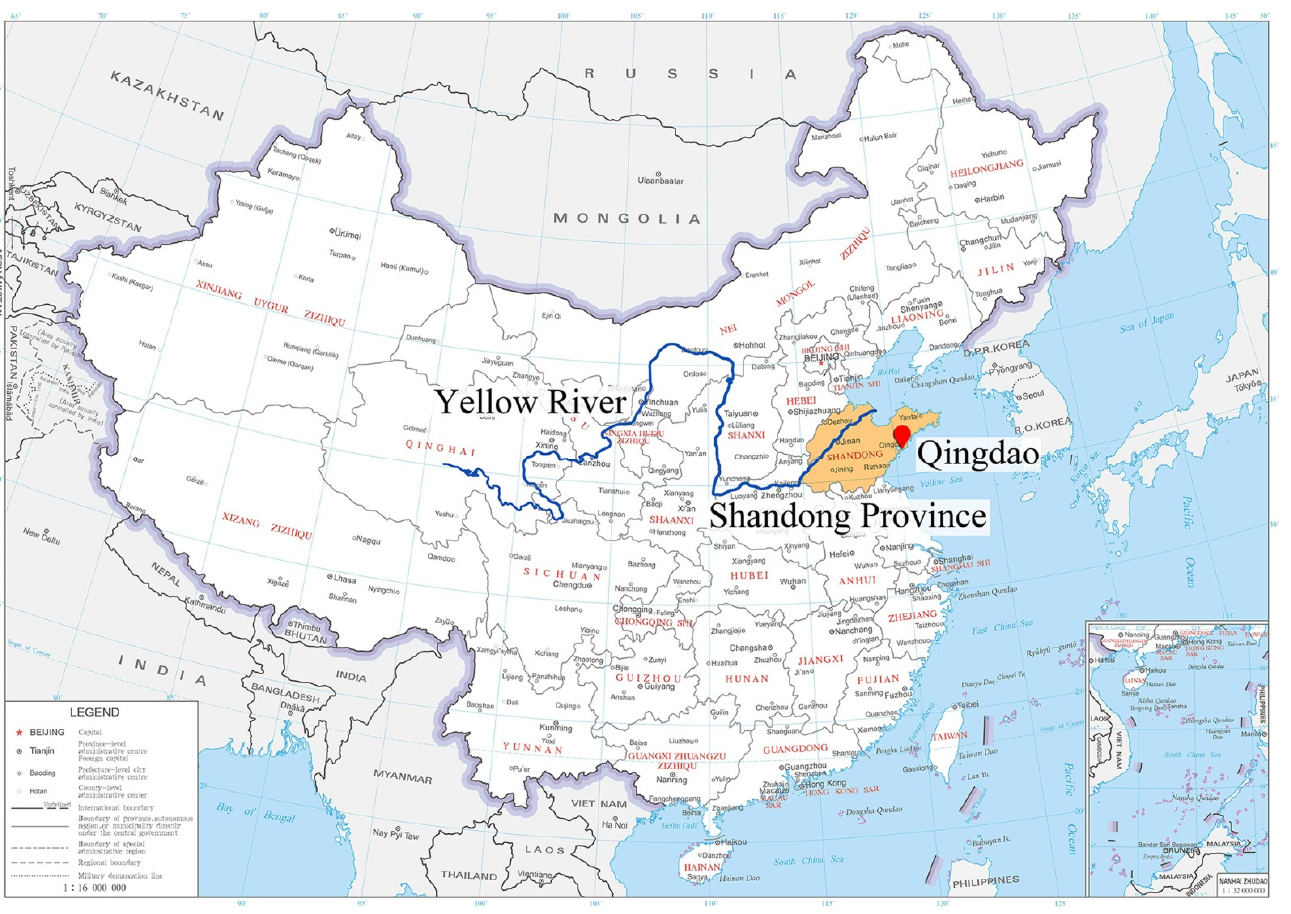
Figure 1. Location of Qingdao in China (based on a map of the People’s Republic of China by the State Bureau of Surveying and Mapping, Map Approval Number: GS(2019)1694).